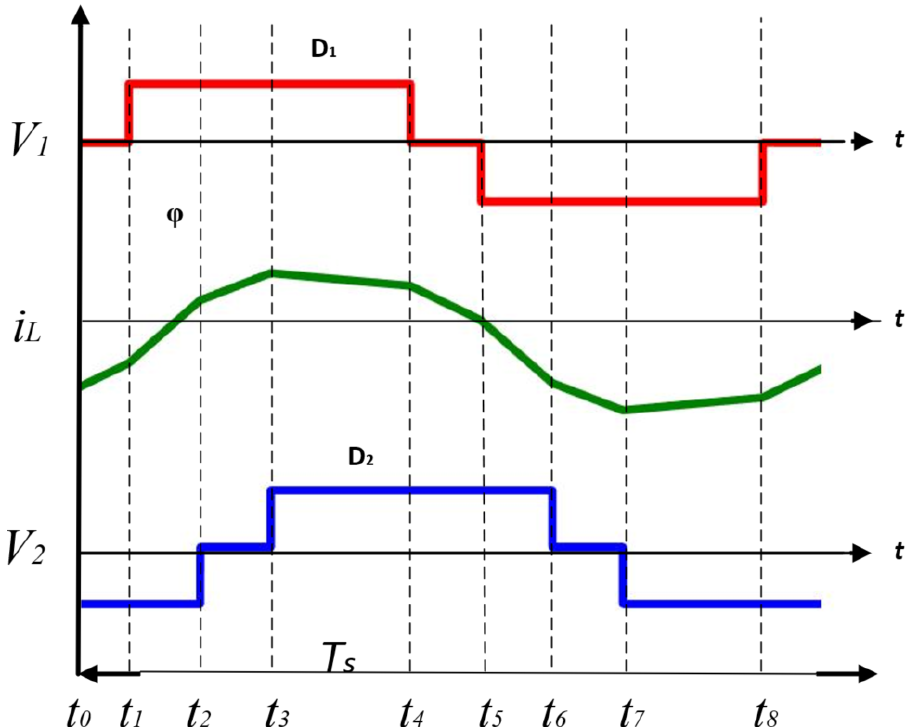
Figure 3. Primary and secondary voltages, and current under the TPS modulation method for Zone-3.